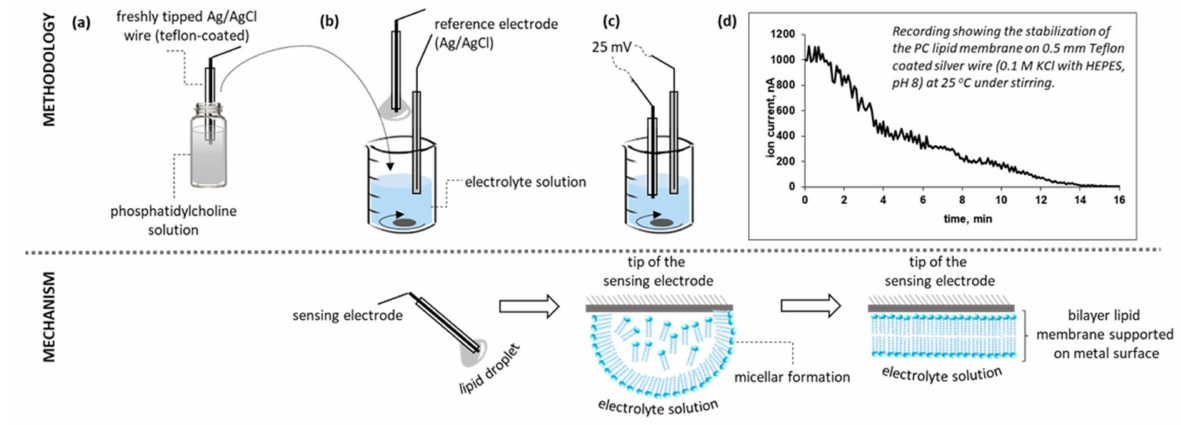
Figure 3. Schematic overview of the construction of the metal-supported bilayer lipid membrane. The stages of the self- assembly process are shown on the lower panels. ( a ) Immersion of the sensing wire into the lipid solution. ( b ) Transfer of wire to the electrolyte solution under stirring. ( c ) Initiation of the self-assembly process. ( d ) Monitoring of the self-assembly process. Please note that the representation of the self-assembly process is only figurative. Not drawn to